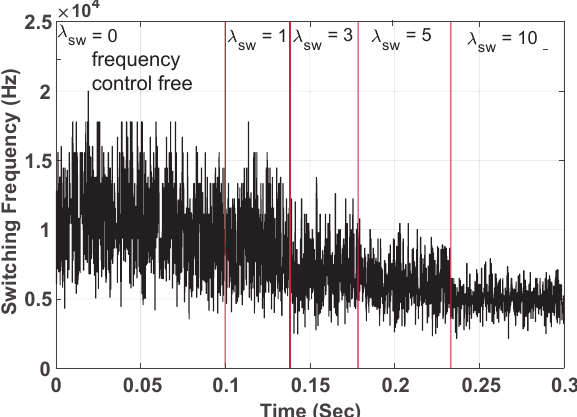
Figure 4. Simulation result for the (SP-CMPC): Switching frequency reduction during sweeping the weighting factor λ sw using the CF in Equation (21) with the conventional tracking system.